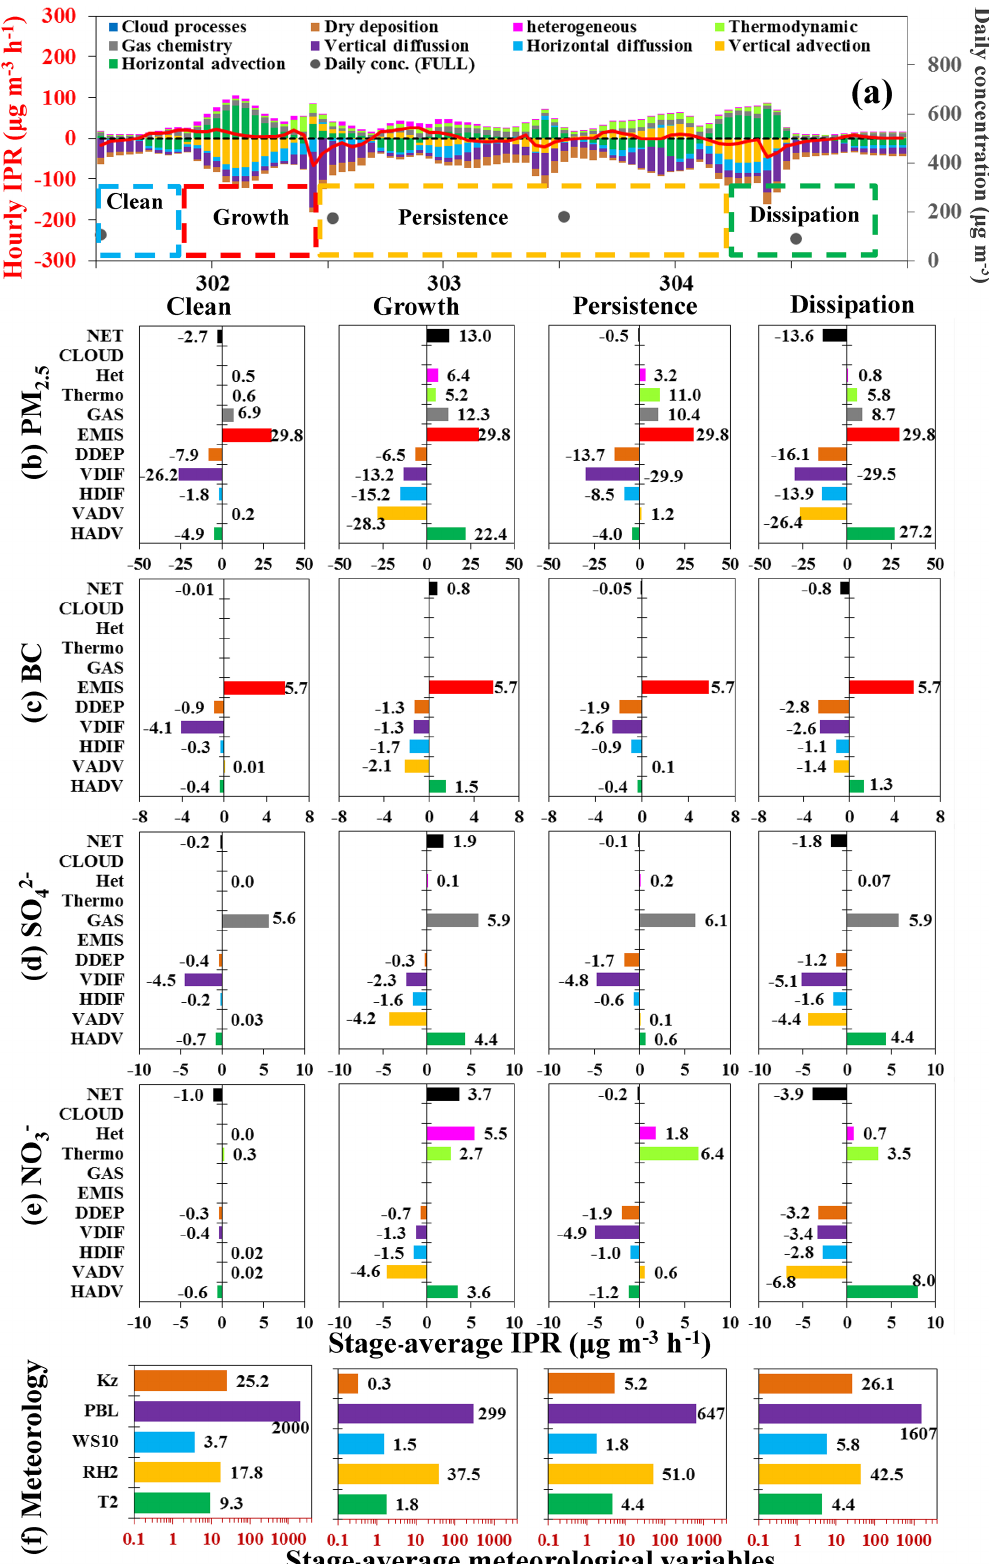
Figure 9. Same as Fig. 8 but for the second haze episode (1–4